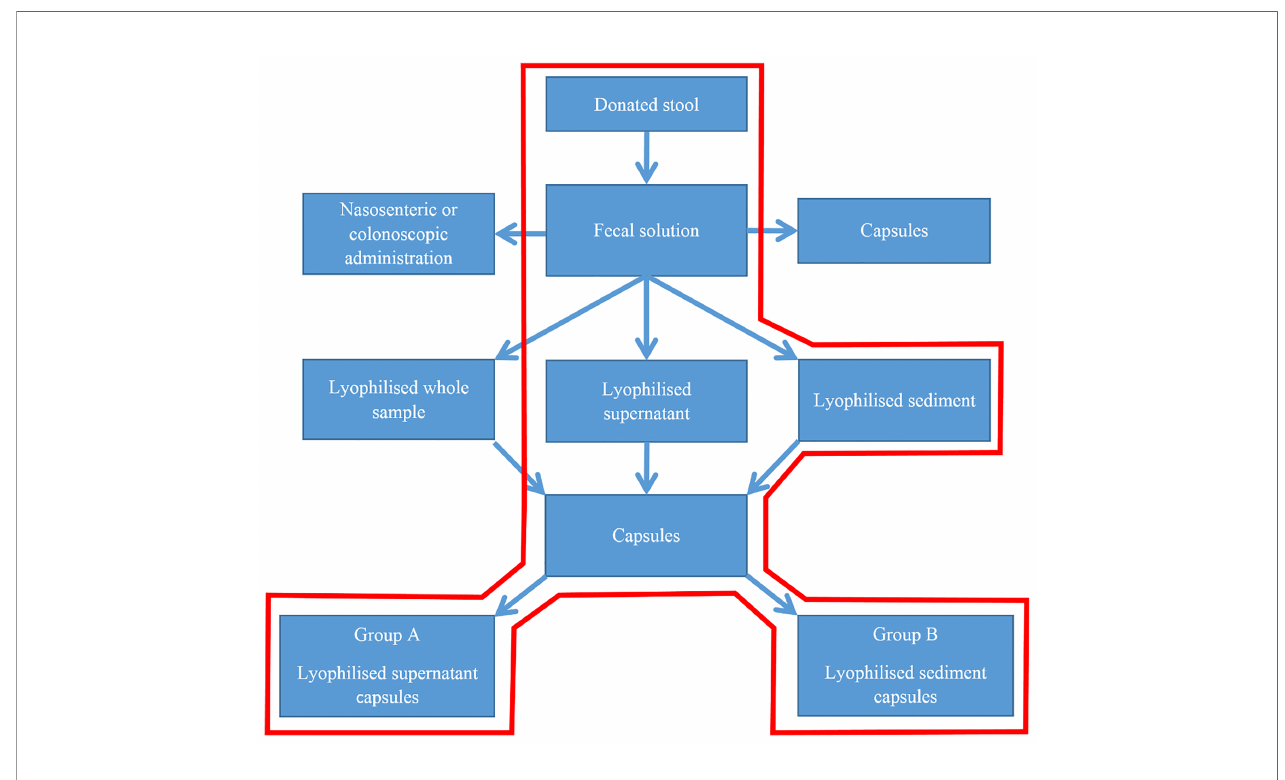
FIGURE 1 | Flowchart of our